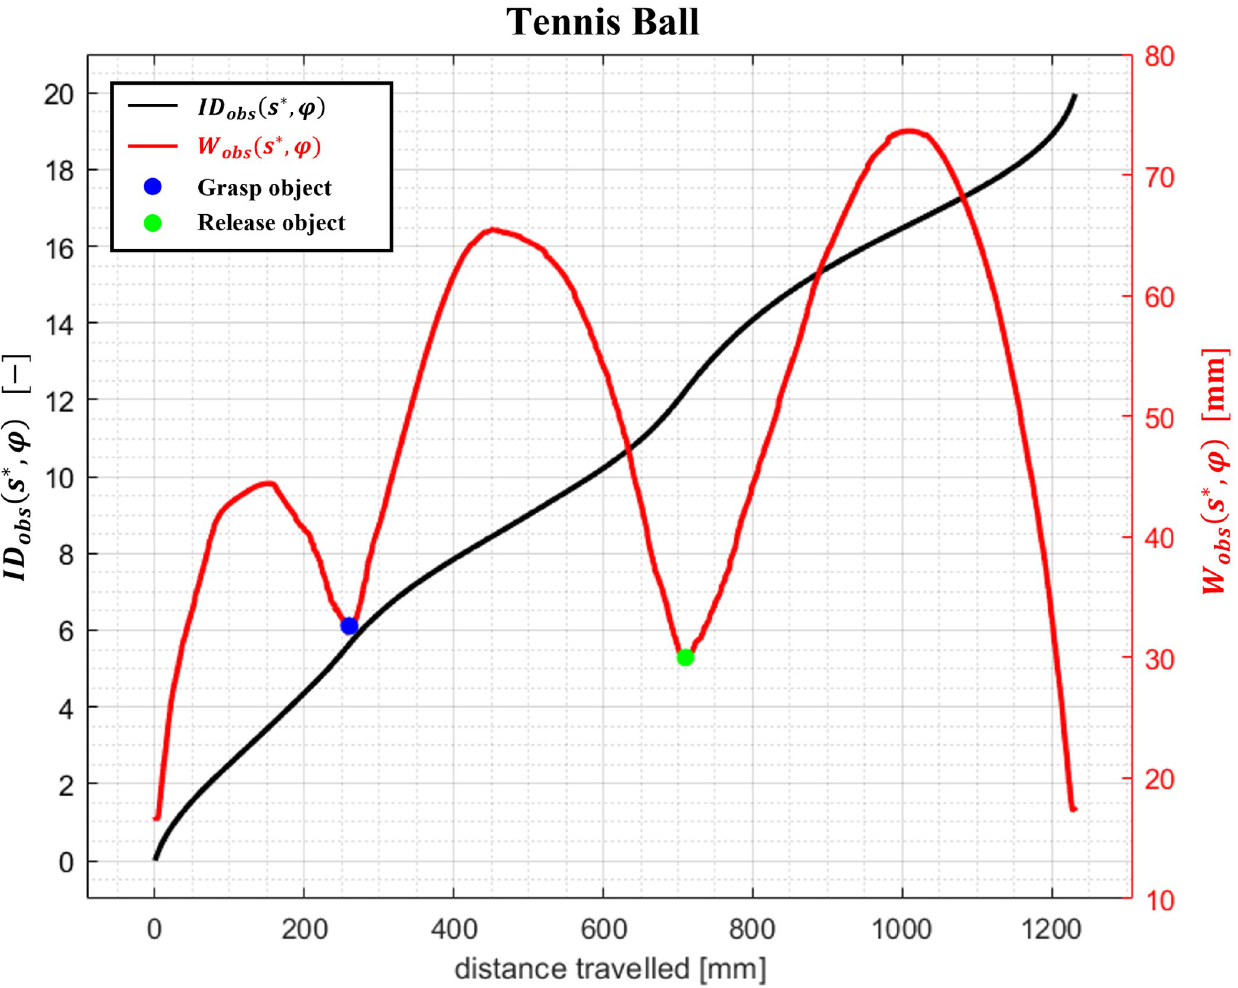
Fig 3. ID obs (s � , φ ) and W obs (s � , φ ) values averaged over 31 subjects during the tennis ball manipulation task.